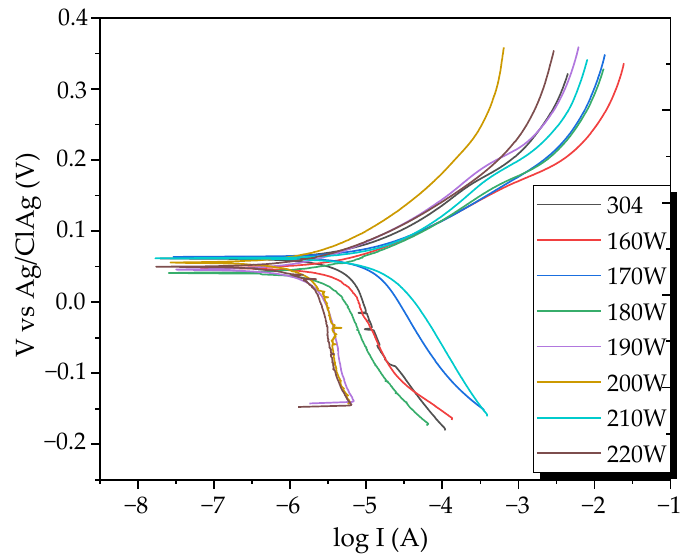
Figure 9. Potentiodynamic polarization for all samples.